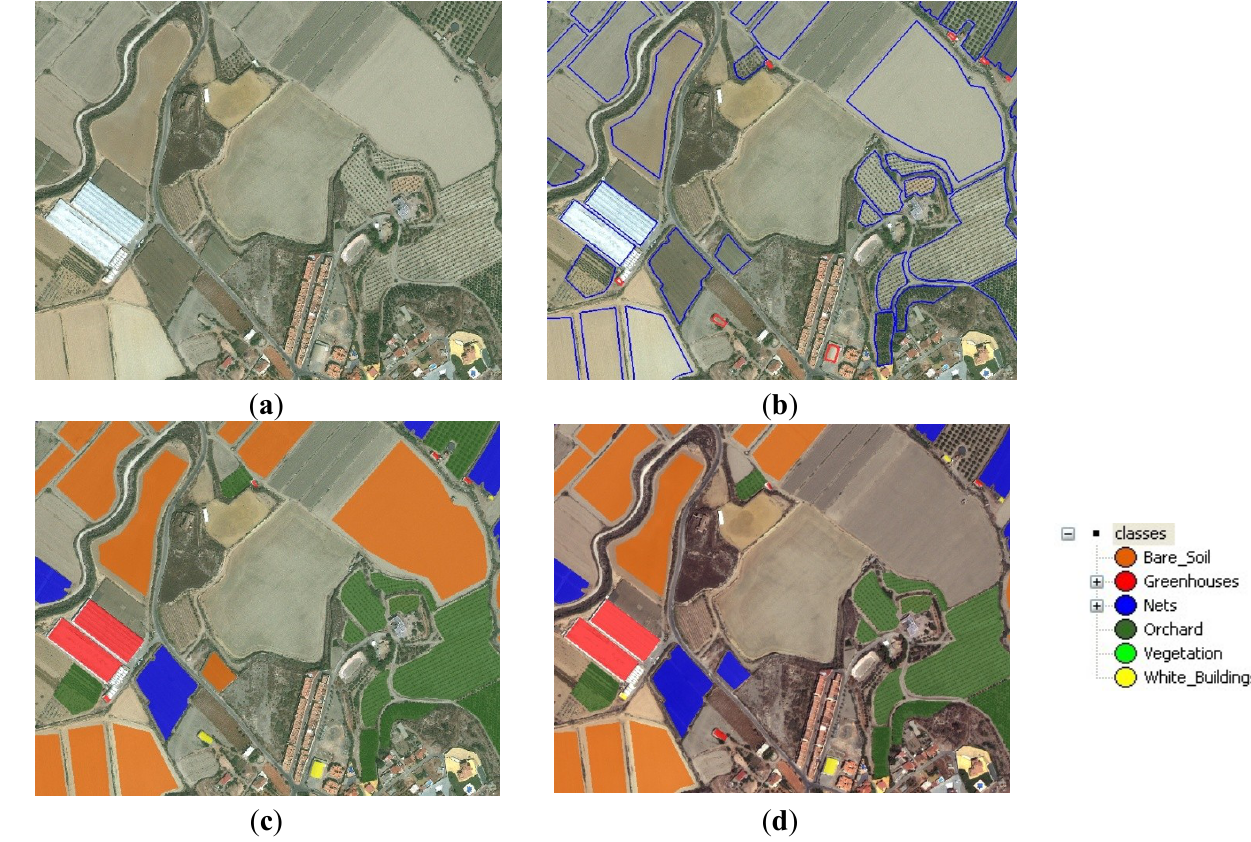
Figure 13. Classification for a detailed area of 700 m × 600 m using NN. ( a ) GE9 pan-sharpened orthoimage; ( b ) segments on GE9 pan-sharpened orthoimage; ( c ) NN classification for single GE9; ( d ) NN classification for single